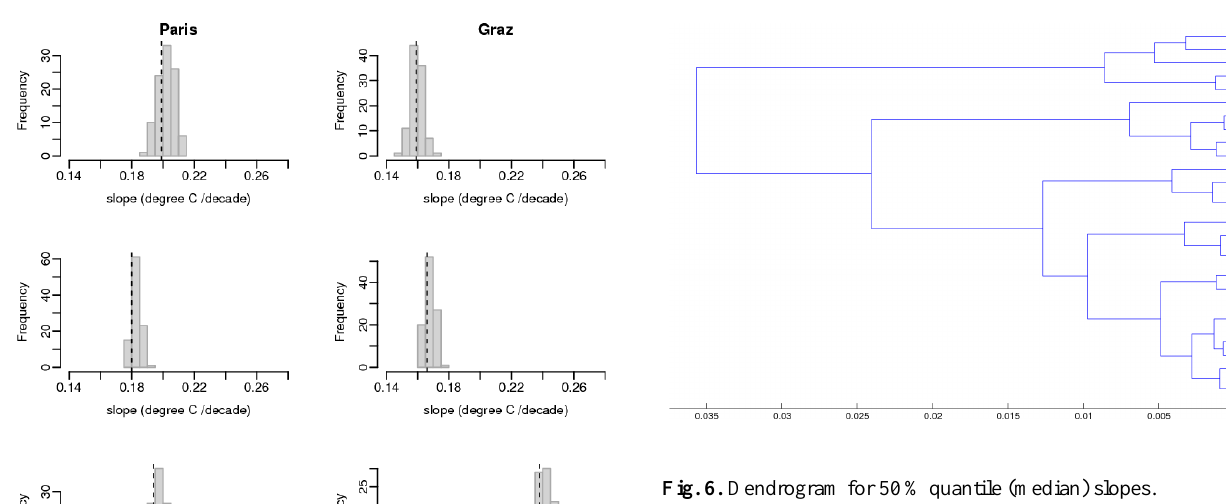
Fig. 6. Dendrogram for 50% quantile (median) slopes.